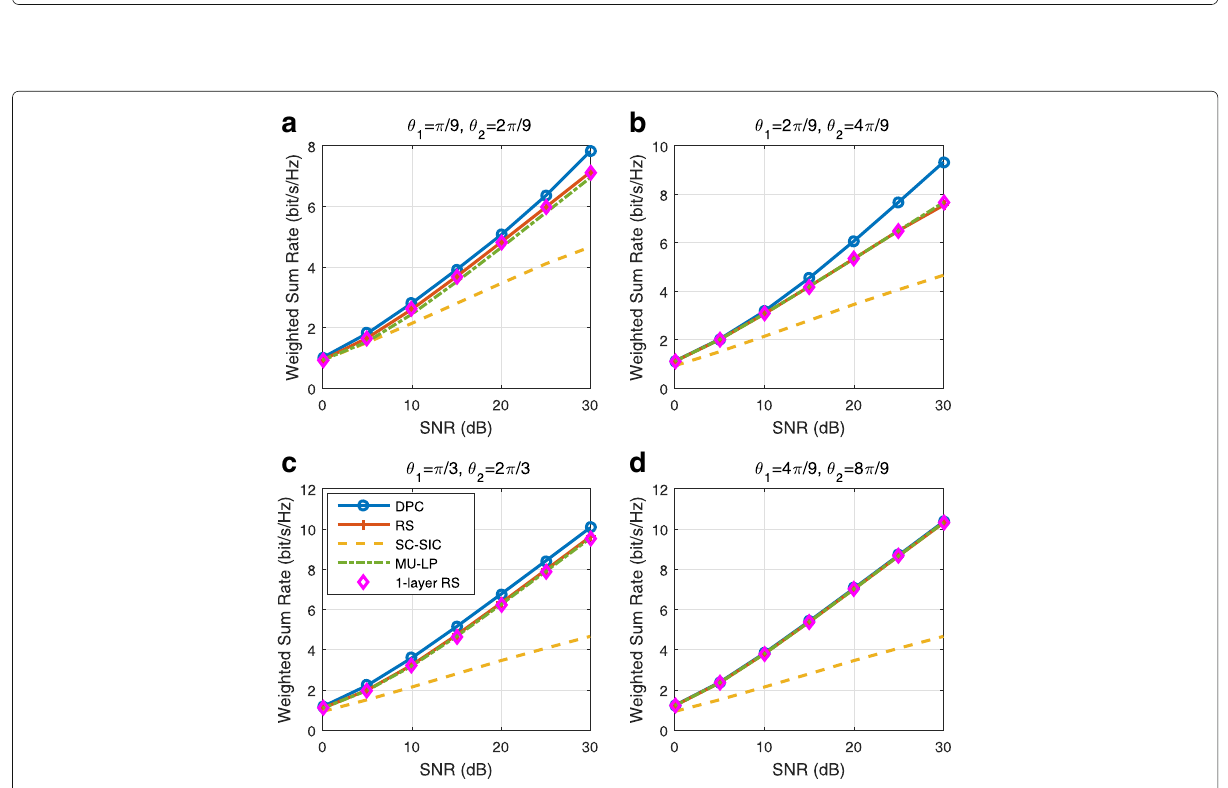
Fig. 33 Weighted sum rate versus SNR comparison of different strategies for underloaded three-user deployment with perfect CSIT, γ 1 = γ 2 = 1, u 1 = 0.4, u 2 = 0.3, u 3 = 0.3, N t = 4, R th